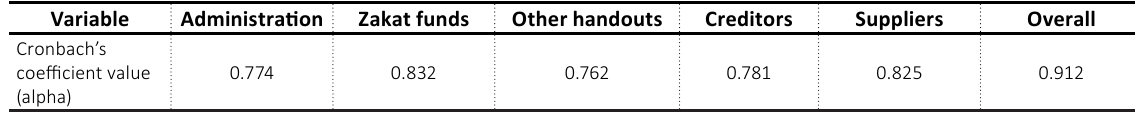
Table 2. The validity and reliability of measurement